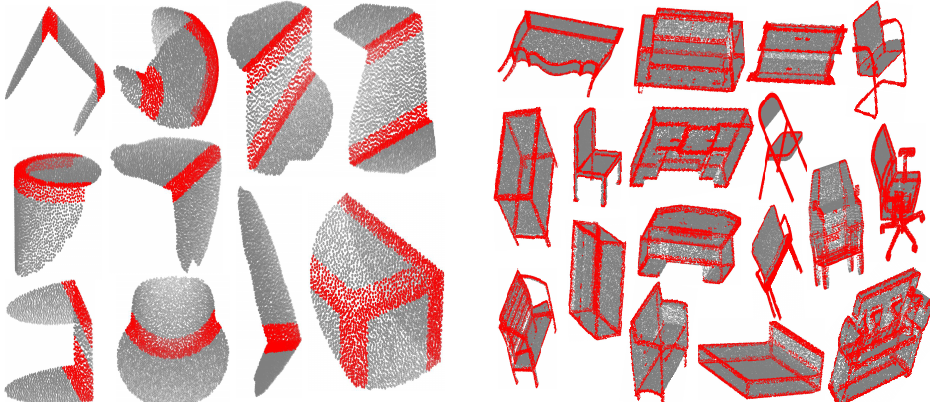
Figure 3. Edge detection results on ABC [35] ( left ) and ShapeNet [34] ( right ) samples. The detected edge points are assigned with red and not-edge points with gray.